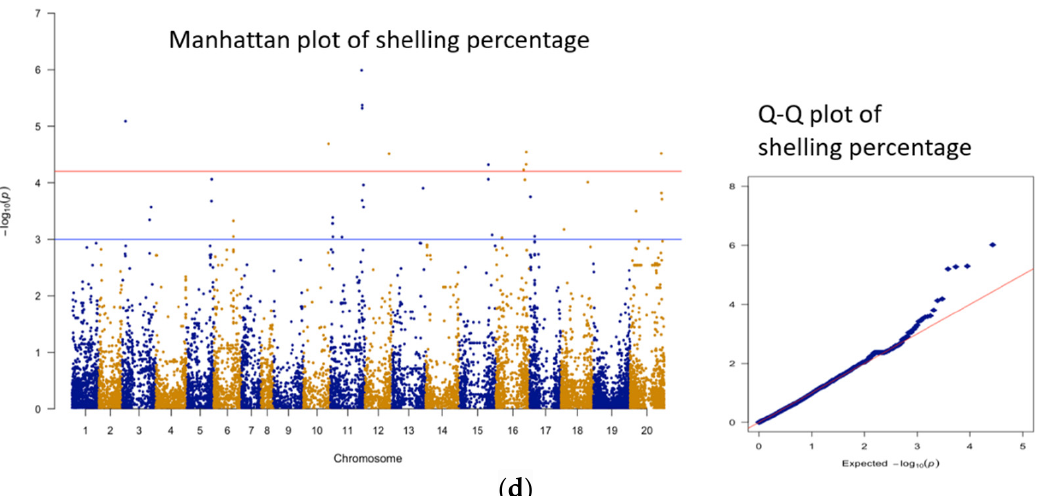
Figure 4. Manhattan and Q − Q plots for seed germination at SMK ( a ), LSK ( b ), 100 seed weight ( c ), and shelling percent ( d ). Significant threshold is marked by a red line, and suggestive threshold is marked by a blue line in the Manhattan plot. Table 5. Significant markers associated with seed grading traits.